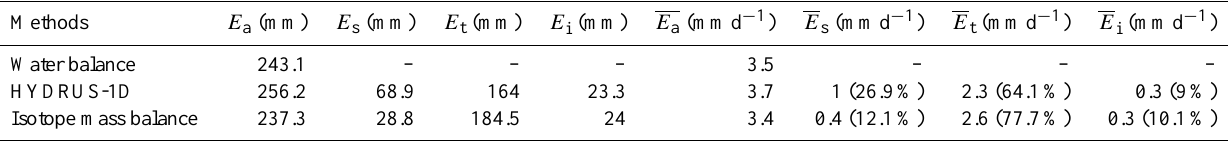
Table 2. Evaporation analysis summary from 16 November 2010 until 27 January 2011. E a is the total evaporation, E s soil evaporation, E t transpiration and E i interception, while E a is the mean total evaporation, E s mean soil evaporation, E t mean transpiration and E i mean